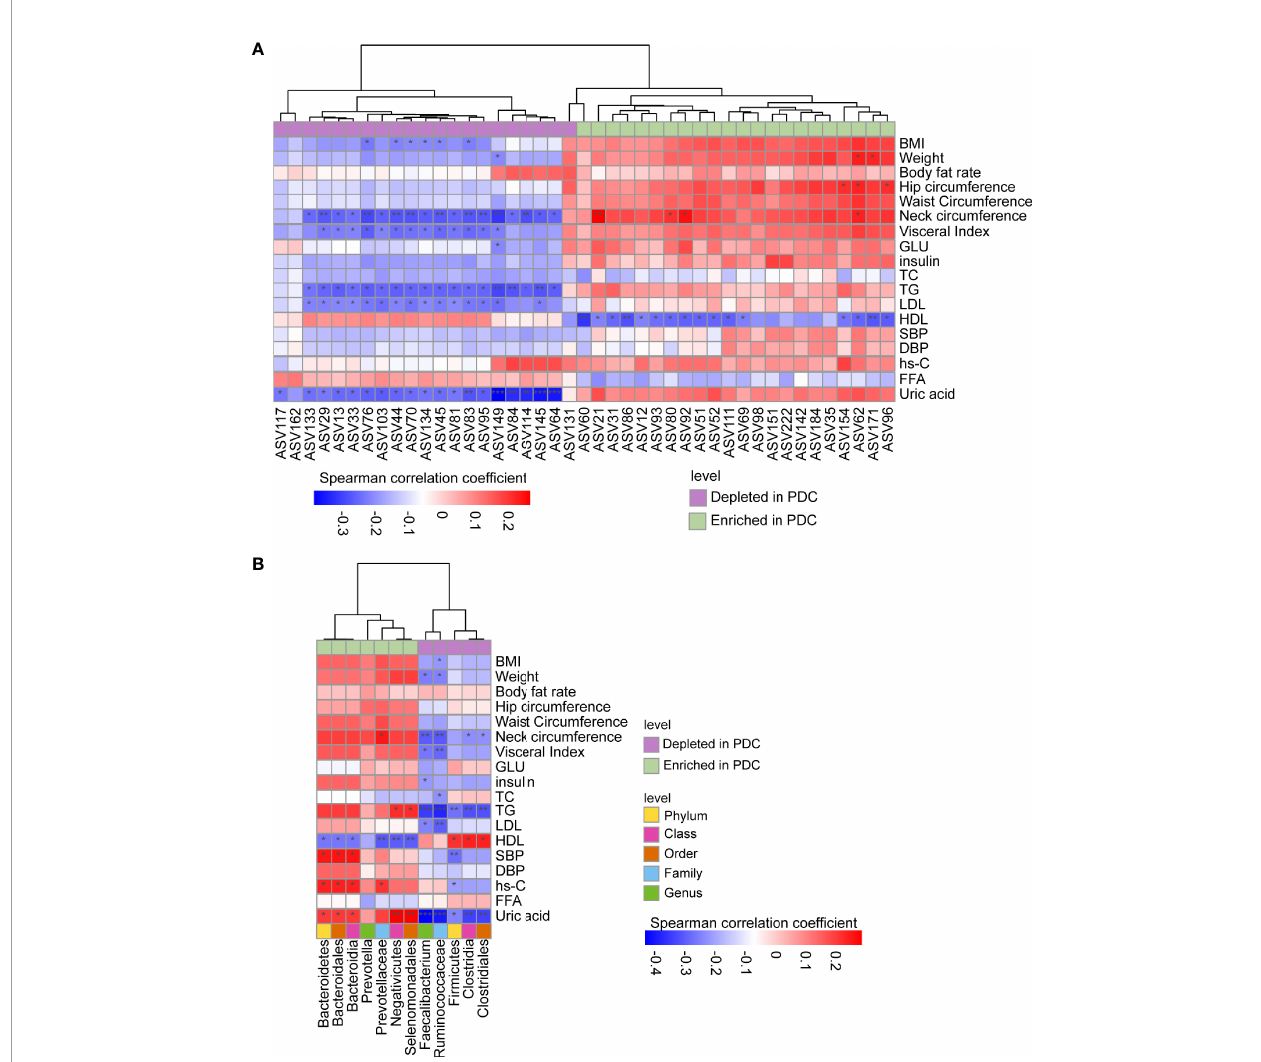
FIGURE 4 | Spearman correlations between PDC-associated gut fl ora and clinical phenotypes. ASVs or taxa enriched in the PDC group were labeled with light green, while depleted ones with purple. (A) Correlations between PDC-associated ASVs and phenotypes. (B) Correlations between discrepant taxa and phenotypes. Note: *, **, *** represent p<0.05, p<0.01, p<0.001,